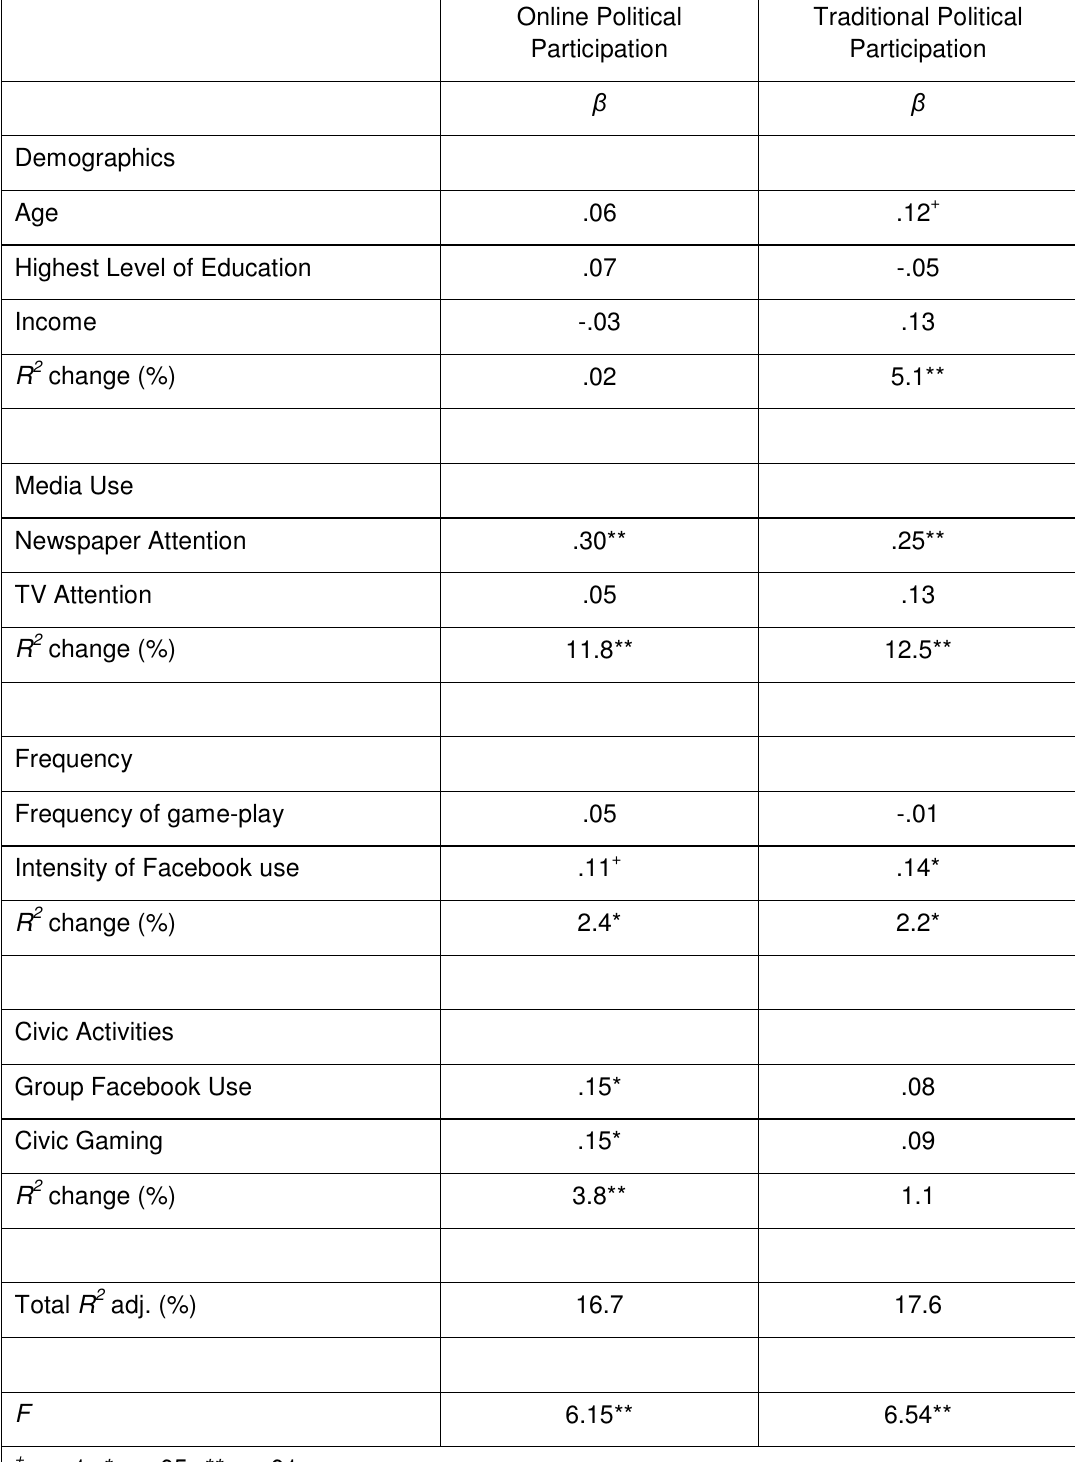
Table 1: Hierarchical Regressions Predicting Political Participation from Demographic, Media Use, Facebook and Gaming Variables (n =